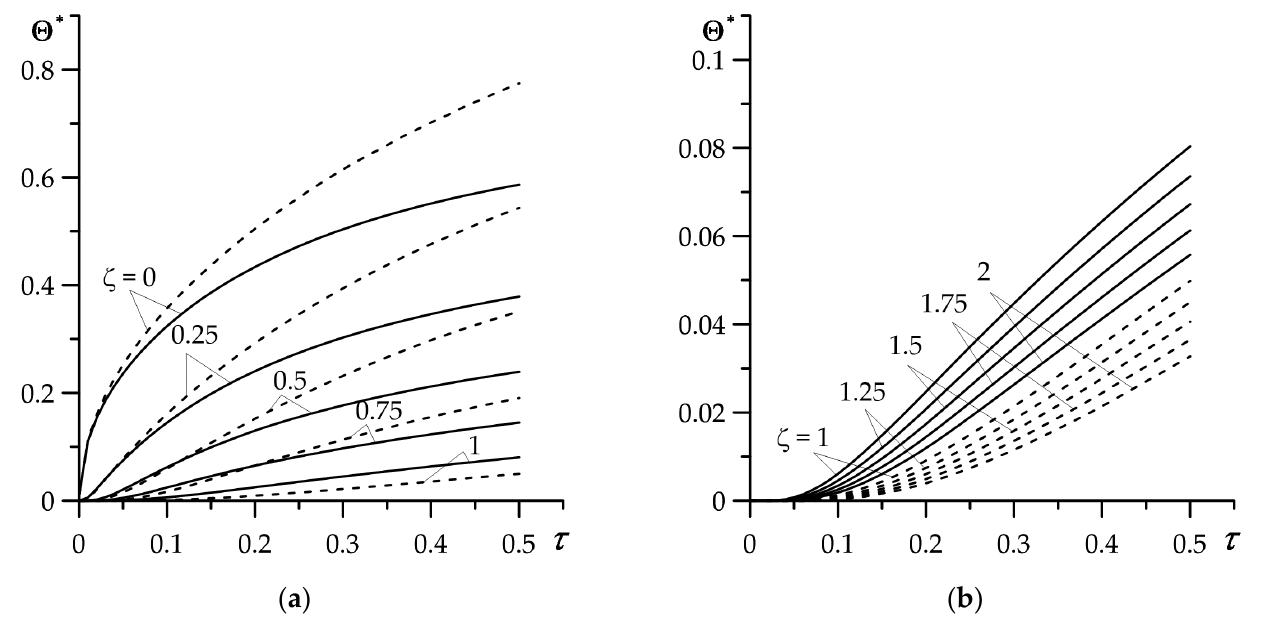
Figure 3. Evolutions of dimensionless temperature rise Θ ∗ ( ζ , τ ) for selected values of dimensionless spatial variable ζ in: ( a ) coating, ( b ) substrate. Solid lines—FGC, dashed lines—homogeneous ZrO 2 coating.